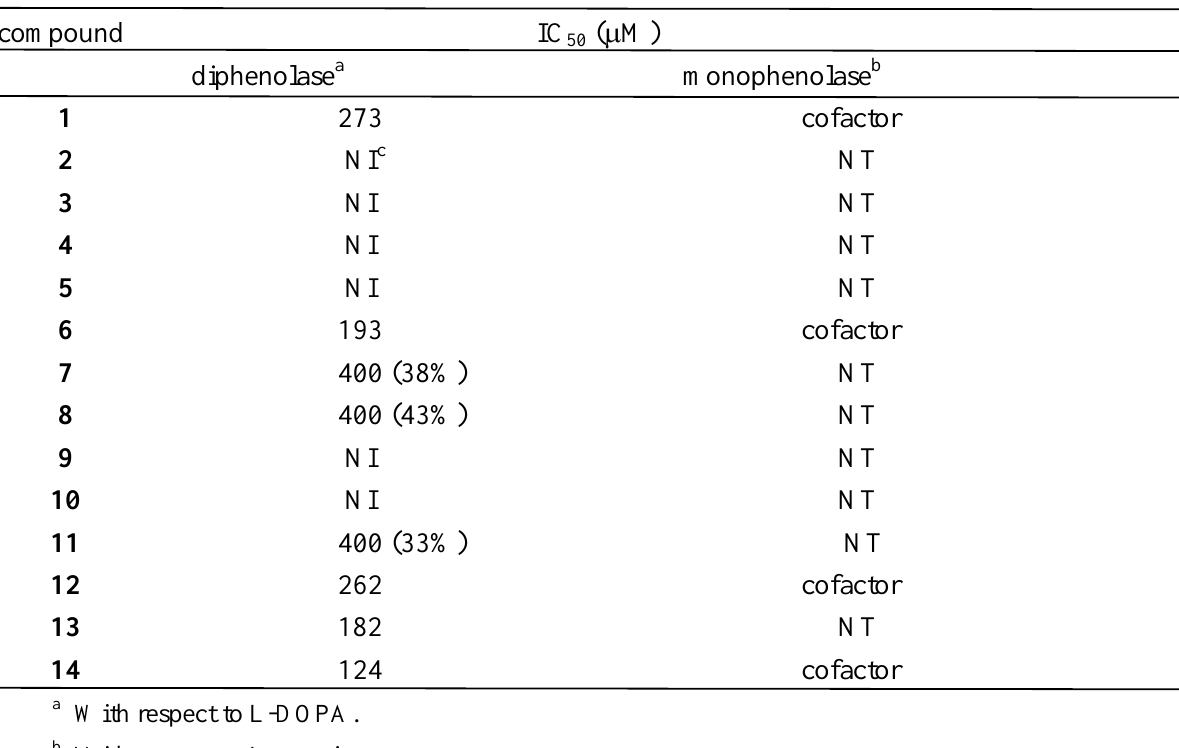
Table 1 . Mushroom tyrosinase inhibitory activities of hydroxyflavones ( 1 - 14